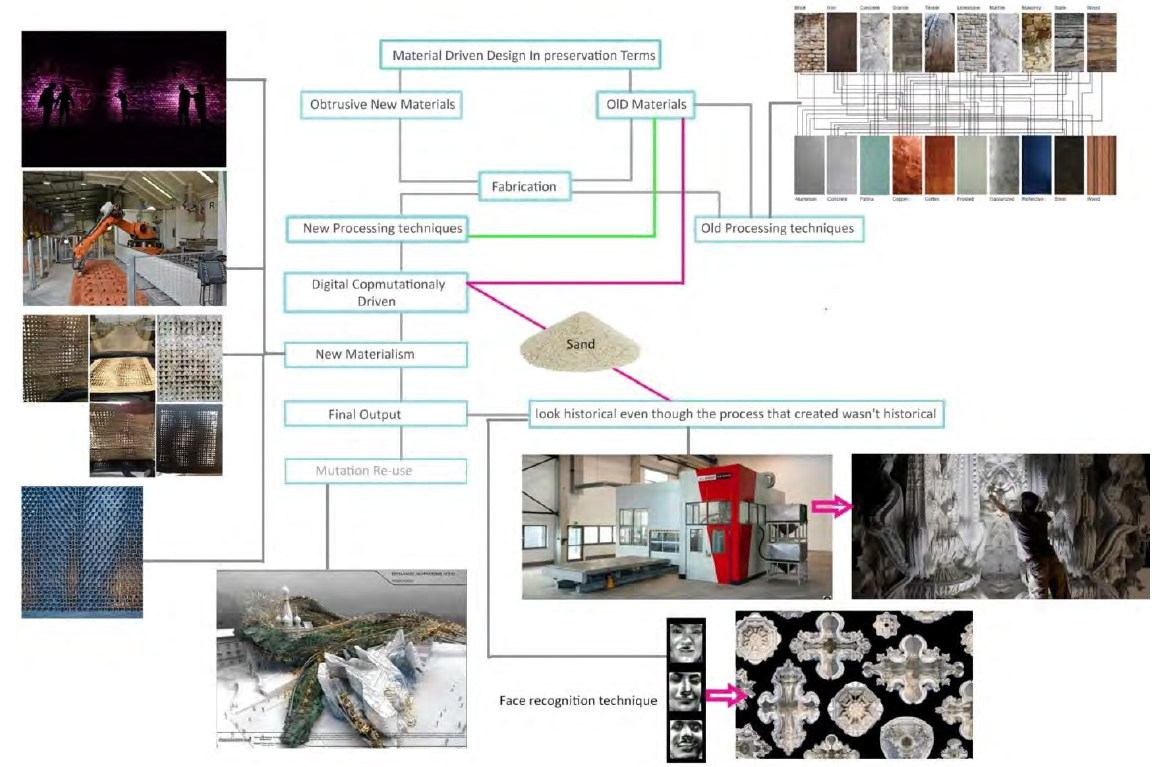
Figure 5. Material strategies processing for old and new materials. Author